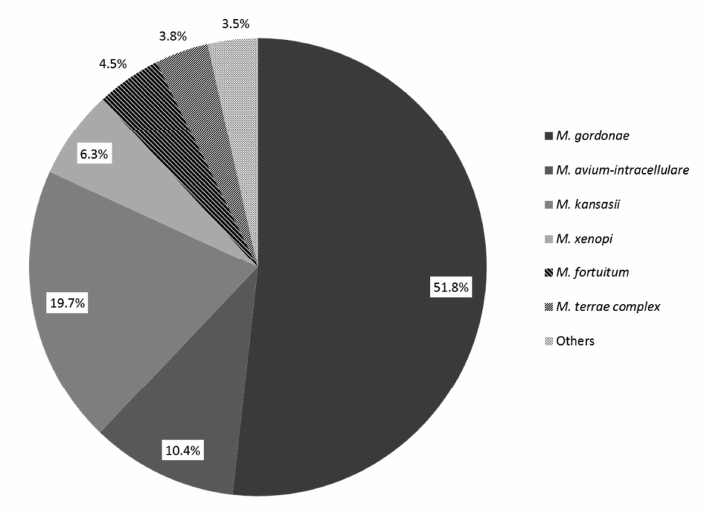
Figure 1. The proportions of environmental mycobacteria detected in treated surface water diluted with mining water intended for the hygiene of employees in large industrial companies and collieries.